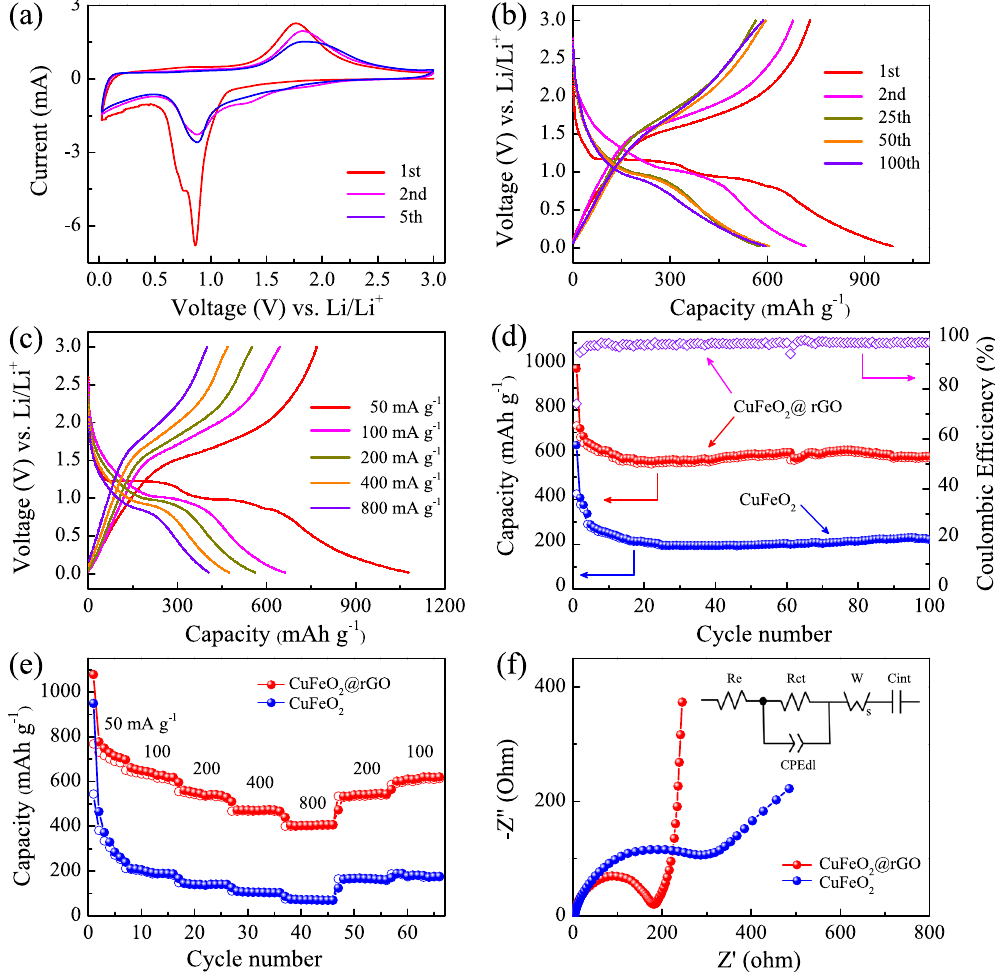
of CuFeO 2 @rGO and CuFeO 2 at 200 mA g − 1 for 100 cycles. ( e ) Rate capabilities of CuFeO 2 @rGO and CuFeO 2 at different current density. ( f ) Nyquist plots and equivalent circuit of CuFeO 2 and CuFeO 2